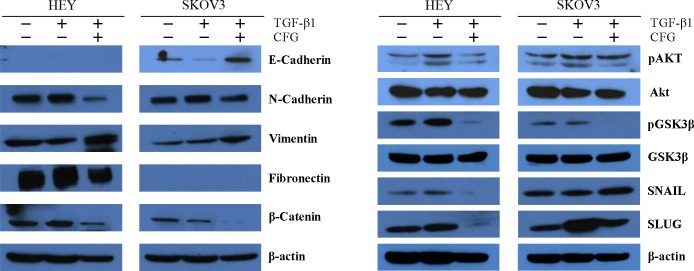
CFG downregultates AKT/GSK3β signal pathway and EMT markers.Cells were treated with 3 mg/ml CFG only or in combination with 10 ng/ml TGF β1 for 24 h. The cellular proteins, including E-cadherin, N-Cadherin, Vimentin, Fibronectin, β-Catenin, pAKT, AKT, pGSK3β, GSK3β, SNAIL, and SLUG, were detected by Western blot.